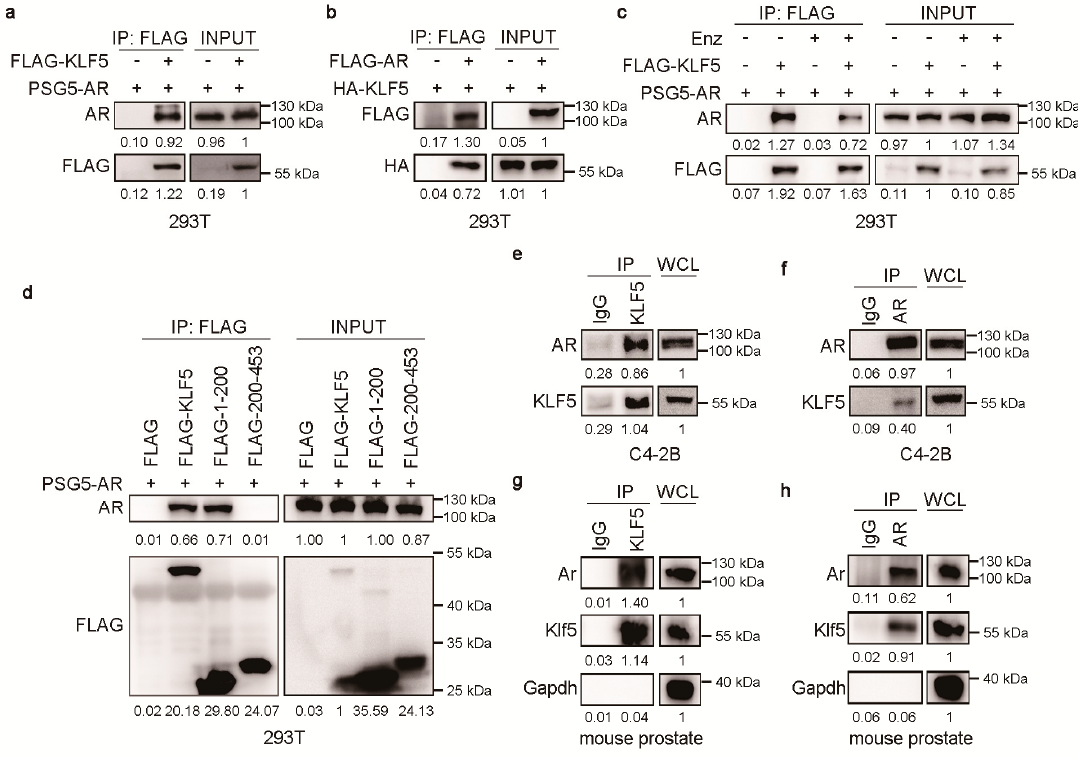
Figure 4. KLF5 physically associates with AR in epithelial cells. ( a , b ) HEK293T cells were transiently transfected with expression plasmids of vector control, Flag-tagged (a) or HA-tagged KLF5 (b), and pSG5-AR (a) or FLAG-tagged AR (b), and then subjected to co-IP with FLAG antibody and western blotting with indicated antibodies. ( c ) HEK293T cells transfected with KLF5 and / or AR as in panel a for 24 h were treated with 10 µ M enzalutamide for 24 h, and then subjected to co-IP and western blotting with indicated antibodies. ( d ) Mapping of interacting KLF5 regions that interact with AR by co-IP with Flag antibody and western blotting with indicated antibodies in HEK293T cells expressing AR and di ff erent fragments of KLF5. ( e , f ) Detection of endogenous KLF5-AR association in C4-2B cells by co-IP with KLF5 (e) or AR antibody (f) and western blotting with indicated antibodies. WCL is whole cell lysates before IP. IgG was used as a negative control for co-IP. ( g , h ) Detection of the Klf5-Ar association in mouse prostates by co-IP with KLF5 (g) or AR antibody (h) and western blotting with indicated